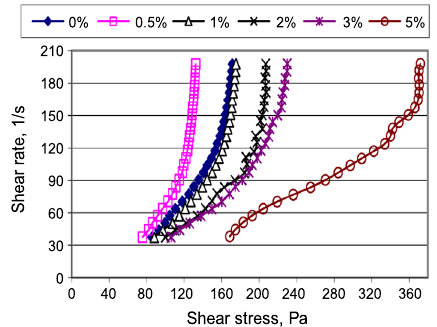
Fig. 5. Cement paste with CEM I R cement shear stress vs shear rate after 120 min